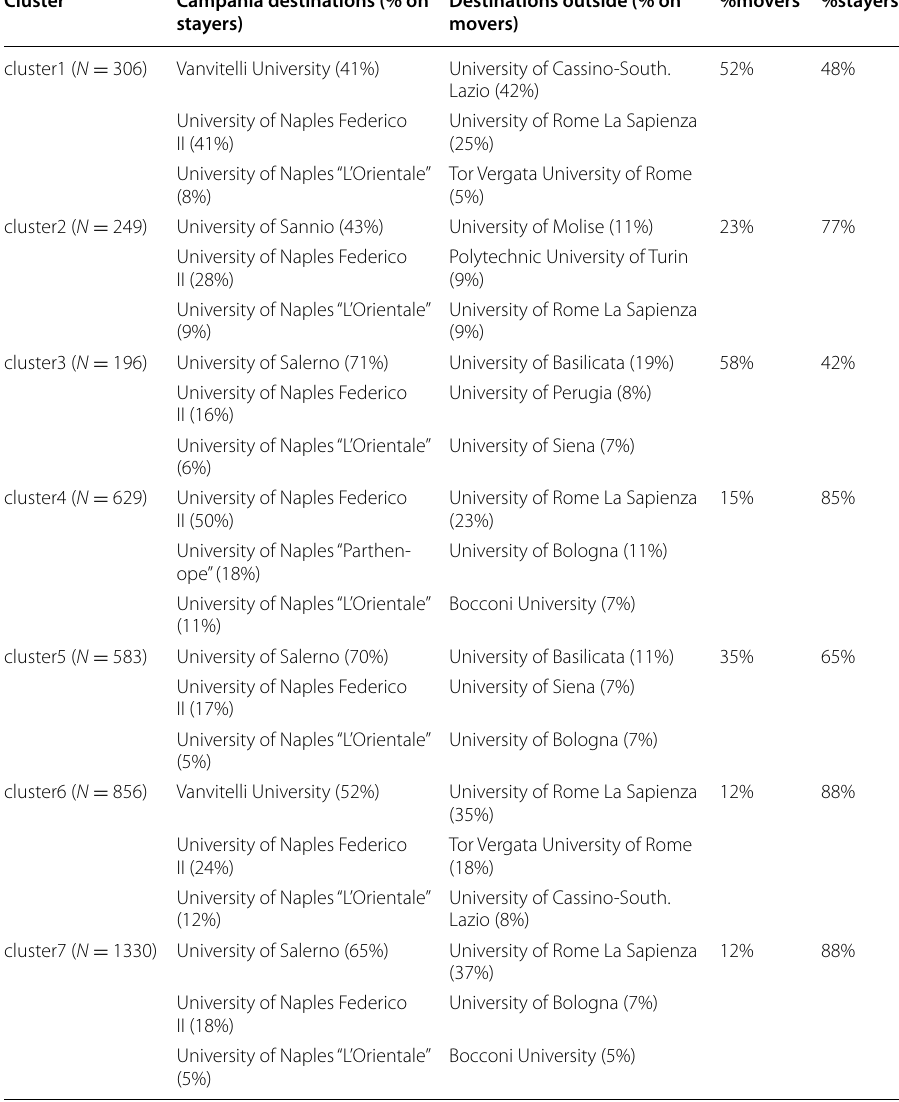
Table 7 Seven clusters identified by random effects. Main destinations in Campania and outside the region. Percentages of movers and stayers. First five clusters present negative effects and last two clusters present positive